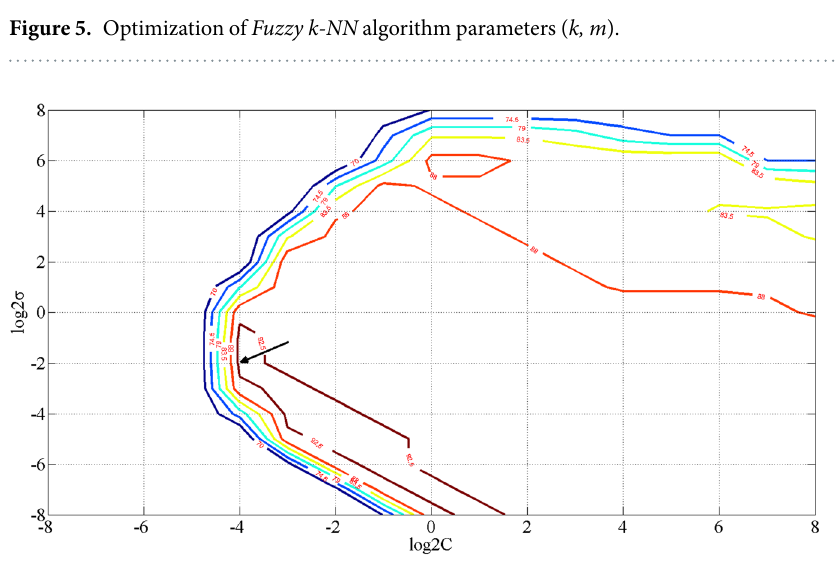
Figure 6. Contour map of PCA-SVM parameter ( C , σ ) optimizing. The arrow is pointing at the optimal parameter by cross validation of the grid